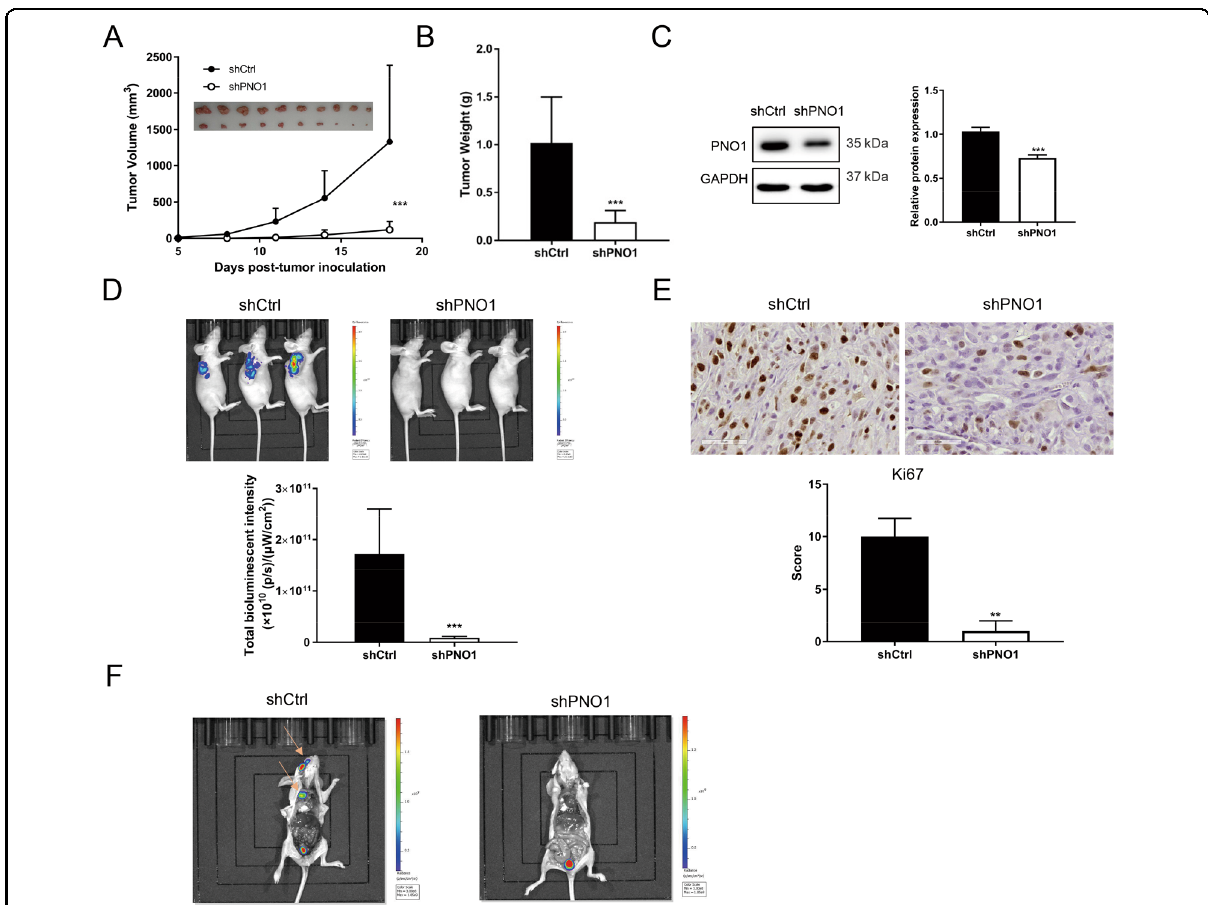
Fig. 3 PNO1 promotes GBM cell proliferation and metastasis in vivo. Mice tumor volume growth curves ( A ) and weight change curves ( B ) for subcutaneous xenografts. n = 10, ***p < 0.001. C Western blotting analyses of PNO1 expression in the indicated tumors. GAPDH was used as a loading control. Each bar represents the mean values ± SD of three independent experiments. *** p < 0.001. D Images of the subcutaneous xenografts from the shPNO1 and shCtrl groups. Images were taken by PerkinElmer IVIS Spectrum ( D , respectively). n = 10, * p < 0.05. E Representative images of sections sliced from the indicated tumors and stained with anti-Ki67, respectively. F Images of the intravenous xenografts from the shPNO1 and shCtrl groups. Images were taken by PerkinElmer IVIS Spectrum